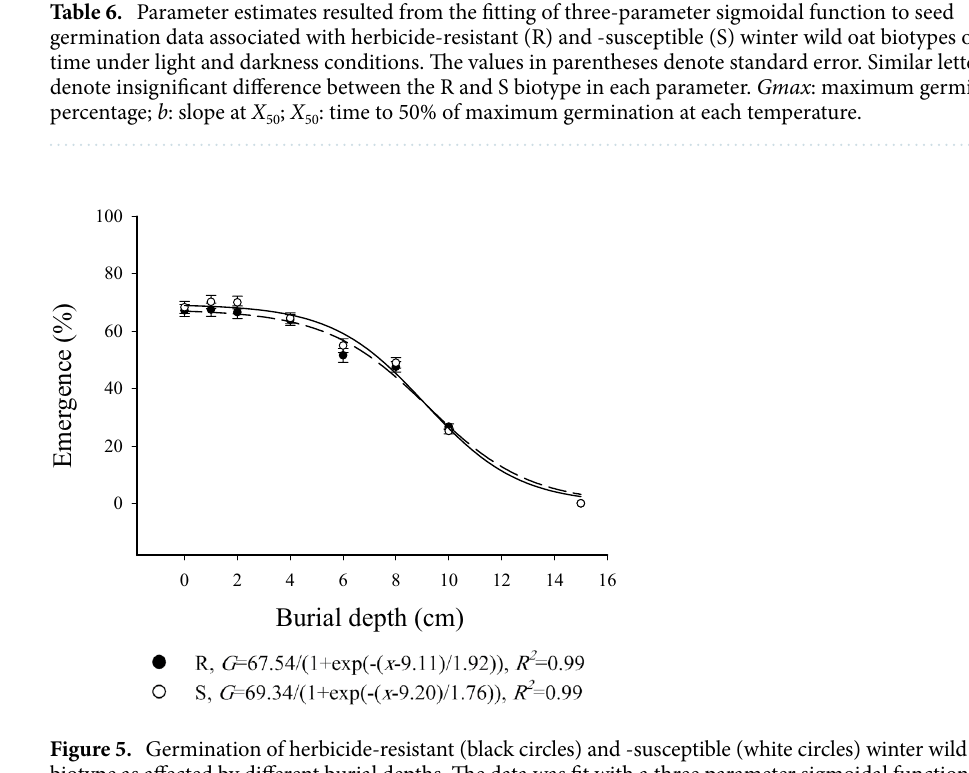
Figure 5. Germination of herbicide-resistant (black circles) and -susceptible (white circles) winter wild oat biotype as affected by different burial depths. The data was fit with a three parameter sigmoidal function using SigmaPlot Version 12.5, from Systat Software, Inc., San Jose California USA, www.systa tsoft ware.com. The statistical analysis was performed using SAS Version 9 software (SAS Institute Inc., Cary, NC,